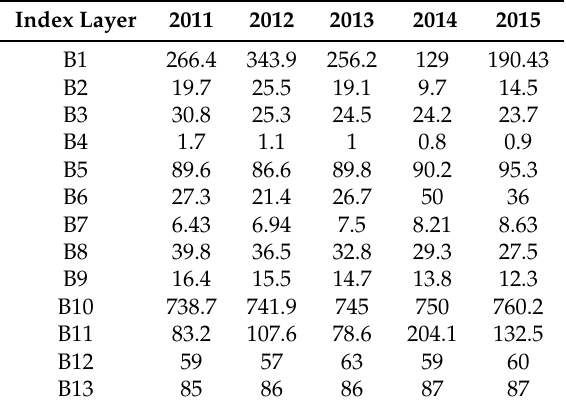
Table 4. Indicator system of the sustainable development of water